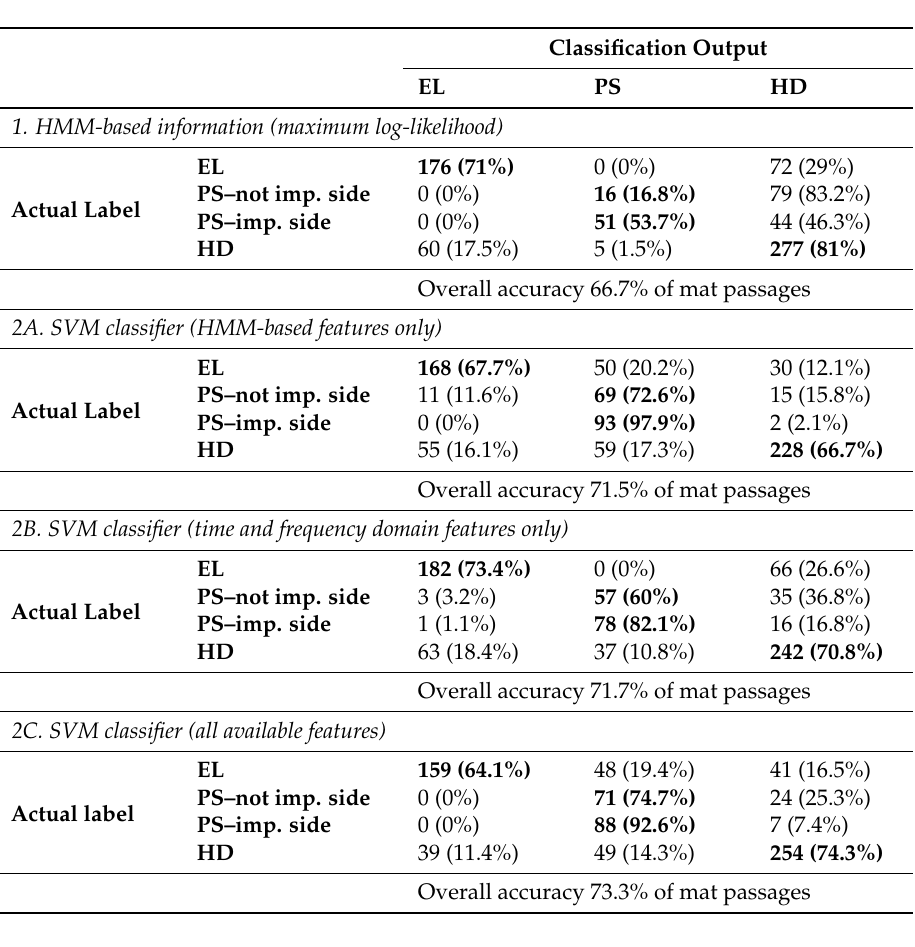
Table 3. Confusion matrices. Results are reported for two different strategies: (1) solving the classification problem using Hidden Markov Models (HMM) based information only; (2) solving the problem using a Support Vector Machine (SVM) classifier. In the latter case, the contributions of HMM-based features only (2A), of time and frequency domain features only (2B) and of the full features set (2C) are presented separately. Confusion matrices refer to the classification of single mat passages: each entry in the matrix corresponds to a passage on the mat of one foot. The amount of passages is then doubled with respect to data in Table 2. Correct classifications are in